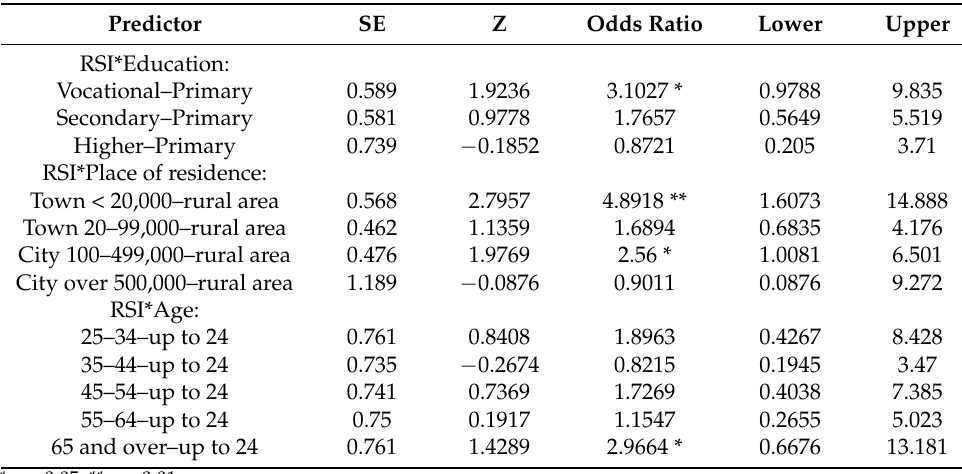
Table 8. Model Coefficients-Cultural Participation (table and